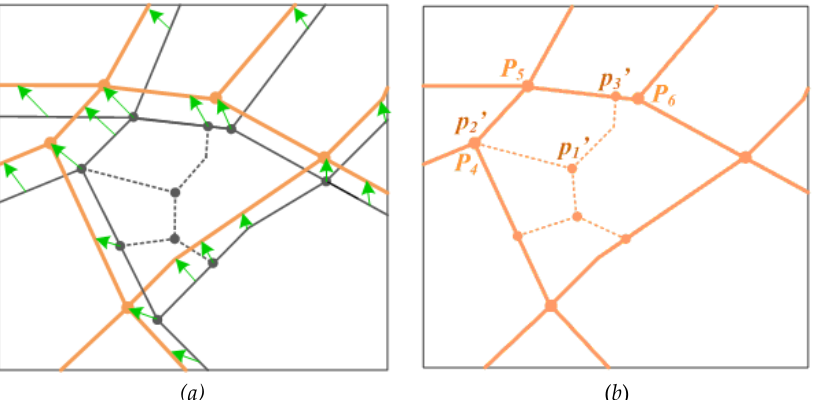
Figure 6. Transformation of PWs-tbc from one road network to the other: ( a ) PWs-tbc before transformation; ( b ) PWs-tbc after transformation. Orange lines: NAVTEQ; grey lines: ATKIS; dashed lines: conflated pedestrian ways; green arrows: linkages (control point pairs).